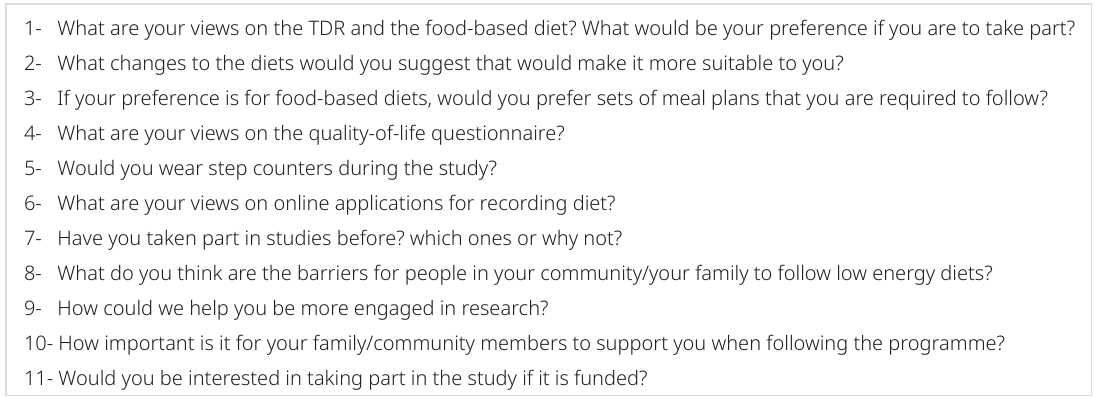
Table 1. Questions asked during both